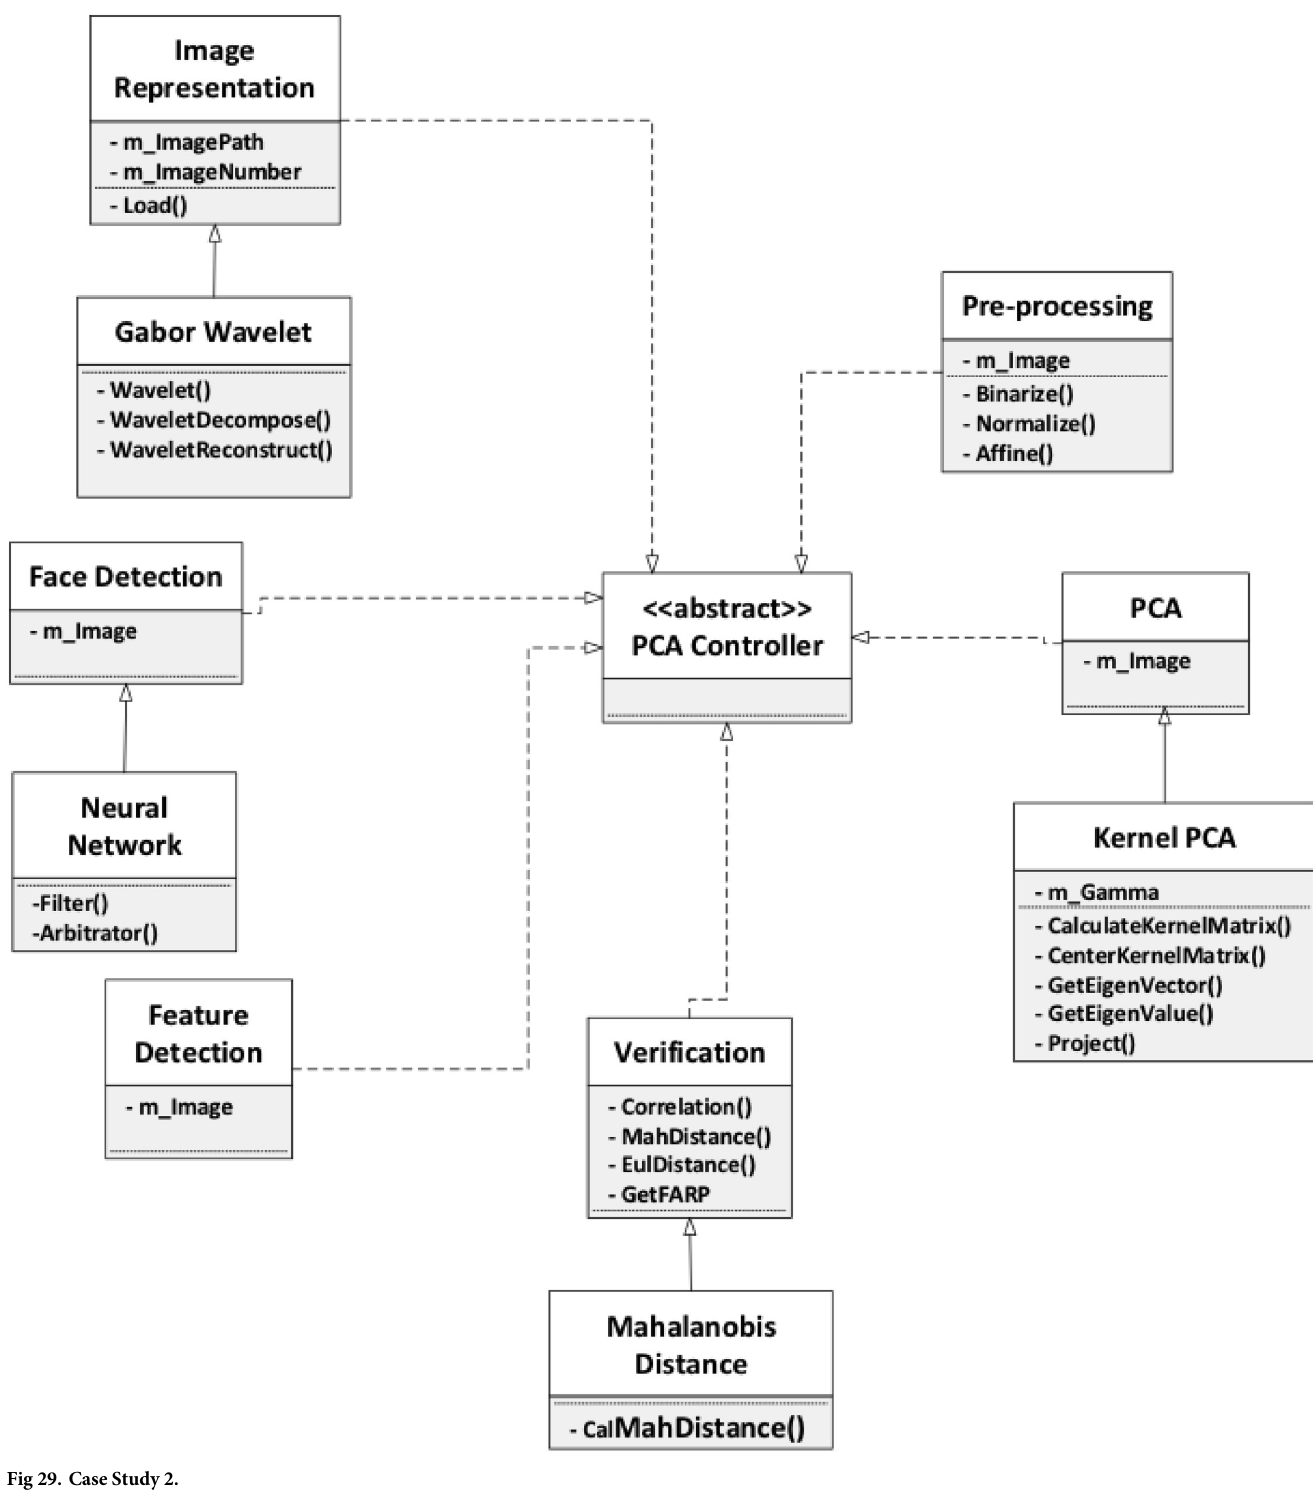
Fig 29. Case Study 2.